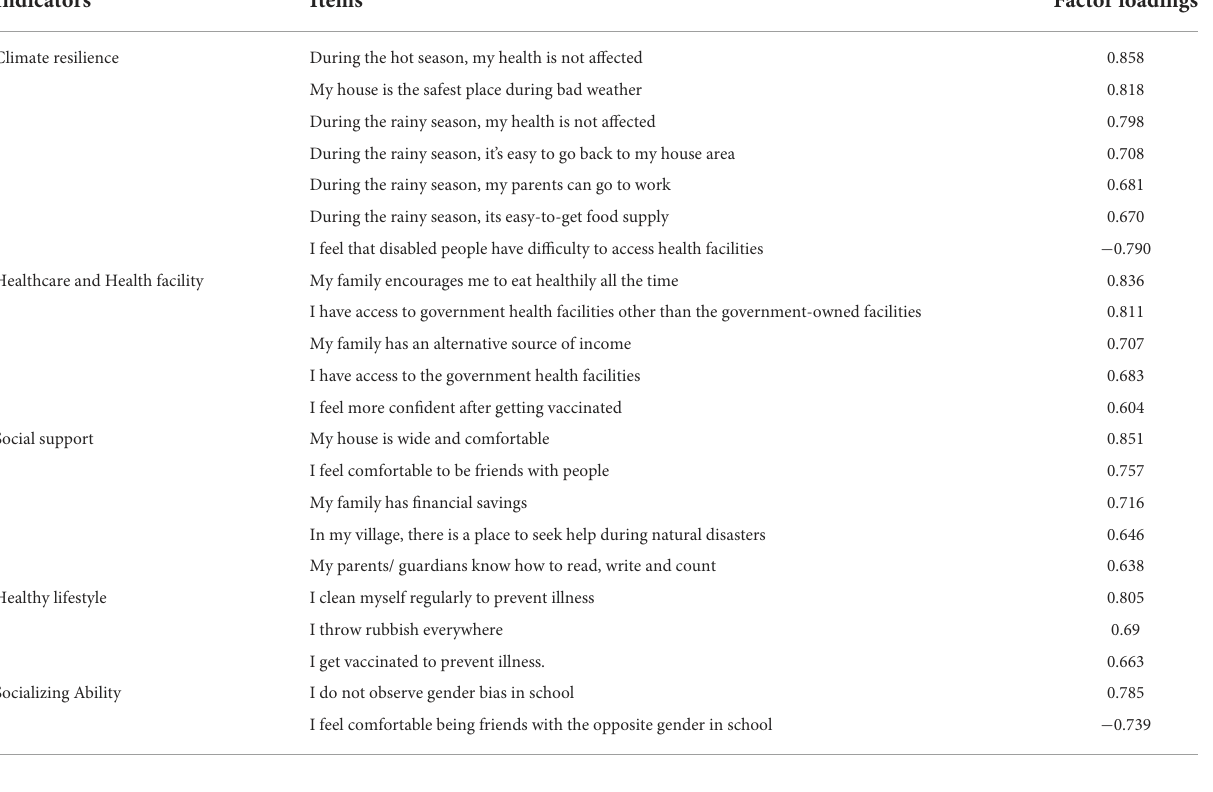
TABLE 8 Indicators and items with respective factor loadings for PPR Sg Bonus, Kuala Lumpur.